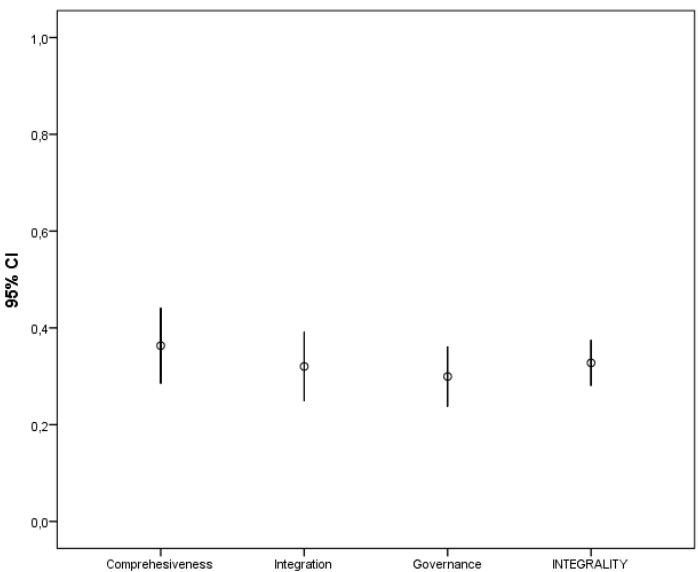
Figure 2. Integrality in the project designs of URBAN and URBANA initiatives in Spain (1994–2013). Error bars (CI 95%). Source: elaborated by the authors.